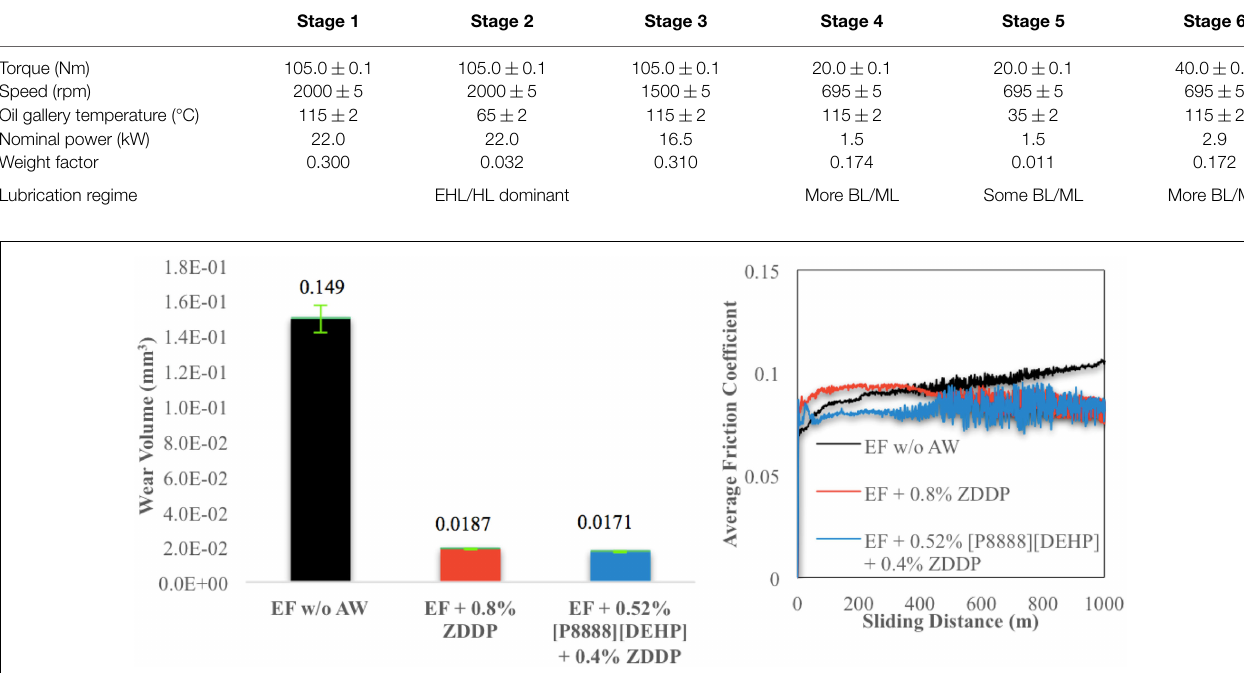
FIGURE 2 | Wear (left, 2a) and friction (right, 2b) results for reciprocating-sliding bench tests . Ball wear volumes (in green on top of each bar) and error bars are included but are very small for the second and third entries. Averaged friction results for two repetitions per